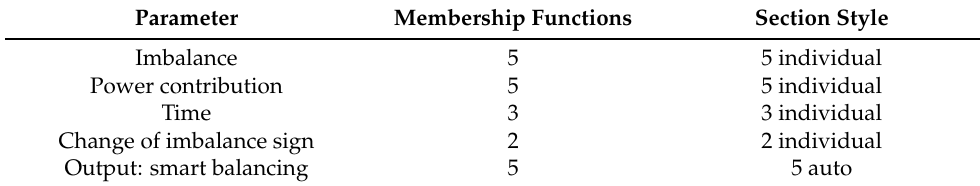
Table A1. Overview of assumed profit optimization parameters of BRP.